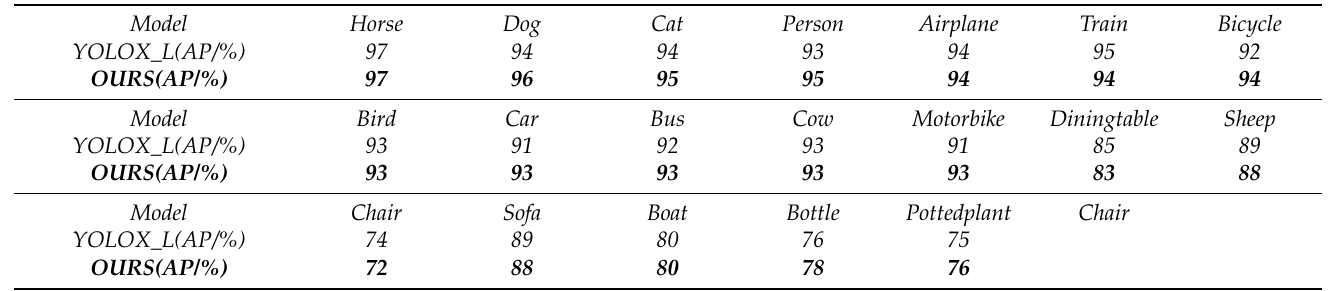
Table 3. Test results of different algorithms for target